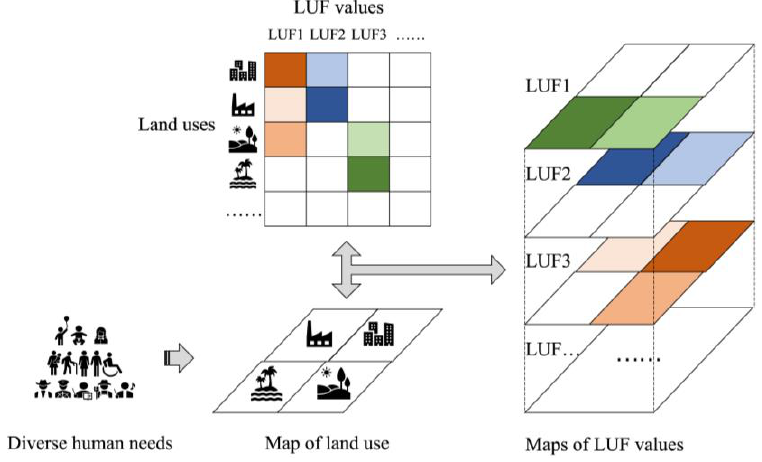
Figure 1. Evaluation framework of land use functional value.